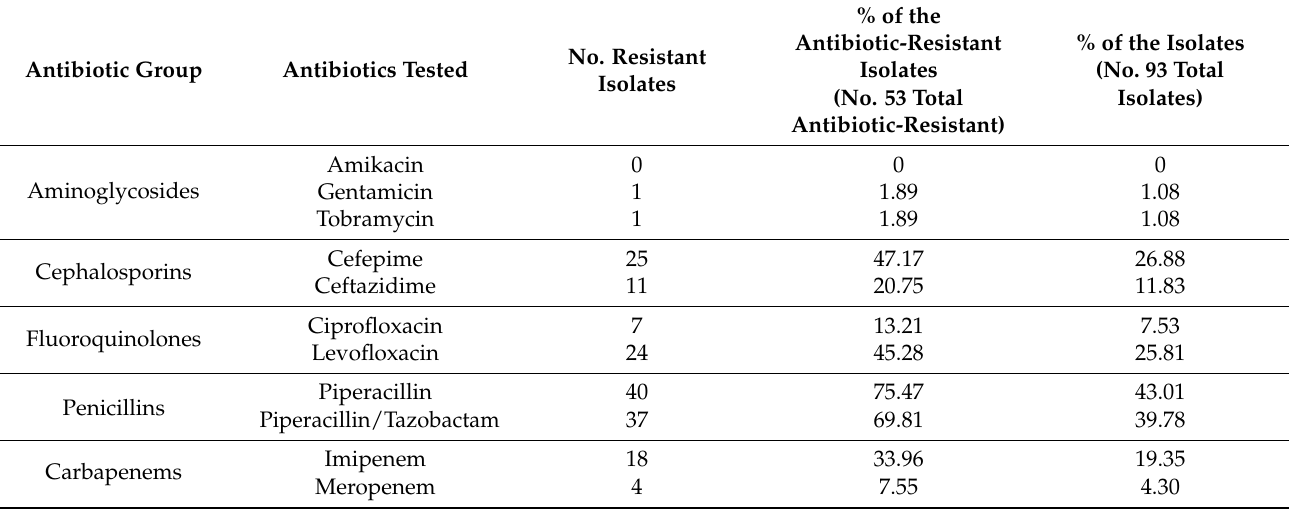
Table 2. P. aeruginosa isolates resistant (R) to the various antibiotics tested.